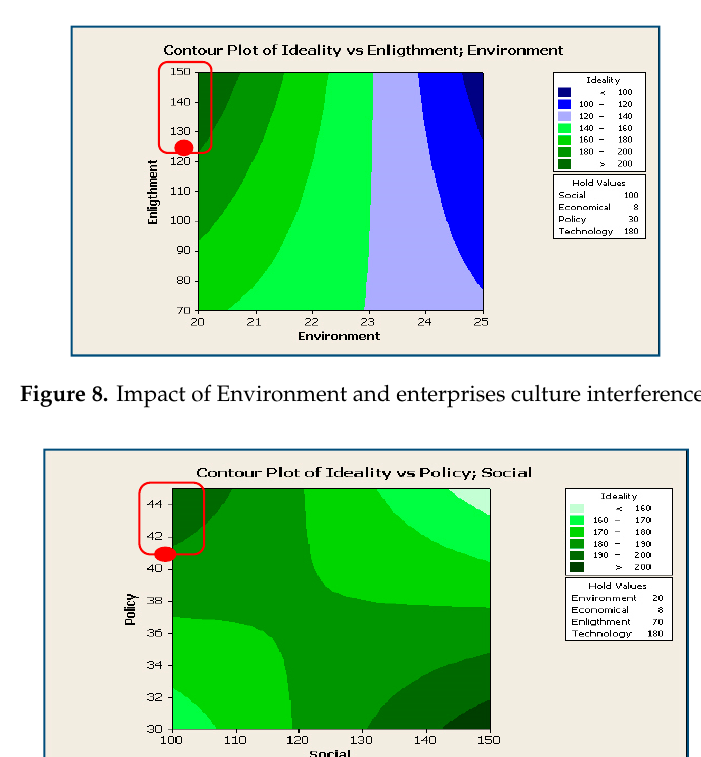
Figure 7. Significance HBL elements on IAPTC (Identify Analysis Perform Track Control) stages and ideality response.